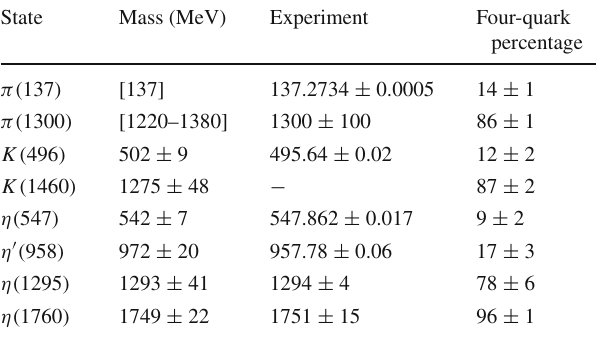
Table 2 Mass and four-quark percentage of the pseudoscalar mesons below and above 1 GeV predicted by the leading order of the GLSM [135]. In first column the masses in the square brackets are inputs and other values are model predictions. The corresponding experimental values reported in PDG [145] are displayed in the second column (for the mass of pion and kaon the average of their charged and neutral masses are extracted from PDG); the last column gives the estimate of the four-quark content of these states. The model predictions have a range of variation that stem from two of the model inputs with large uncertainties ( m [ π( 1300 ) ] = 1 . 22–1.38 GeV and A 3 / A 1 = 27–30). Each predicted quantity in columns one and three is the average of that quantity over its range of variation and its uncertainty is one standard deviation around the average. All displayed masses are in MeV. The predicted properties of states above 1 GeV are expected to improve by inclusion of higher order terms in the potential as well as the scalar and pseudoscalar glueballs